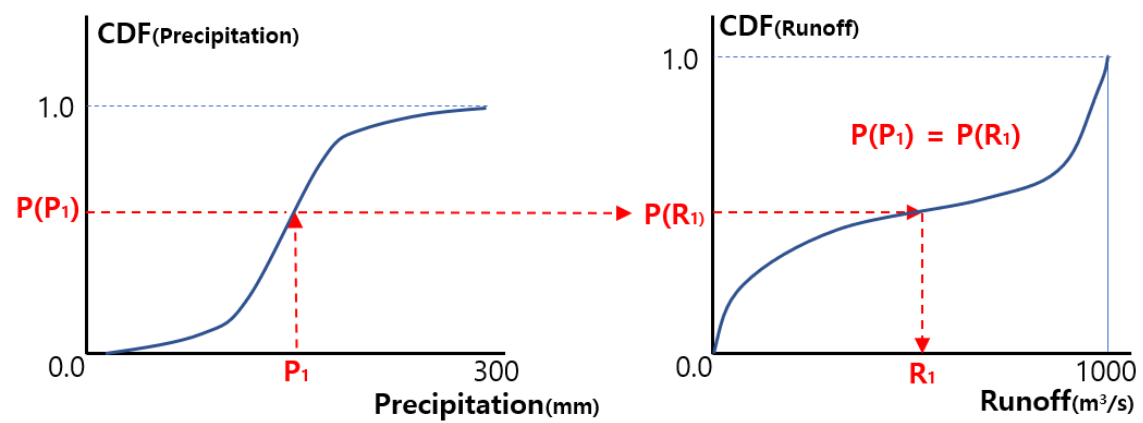
Figure 1. Concept of frequency matching in NRCS method.